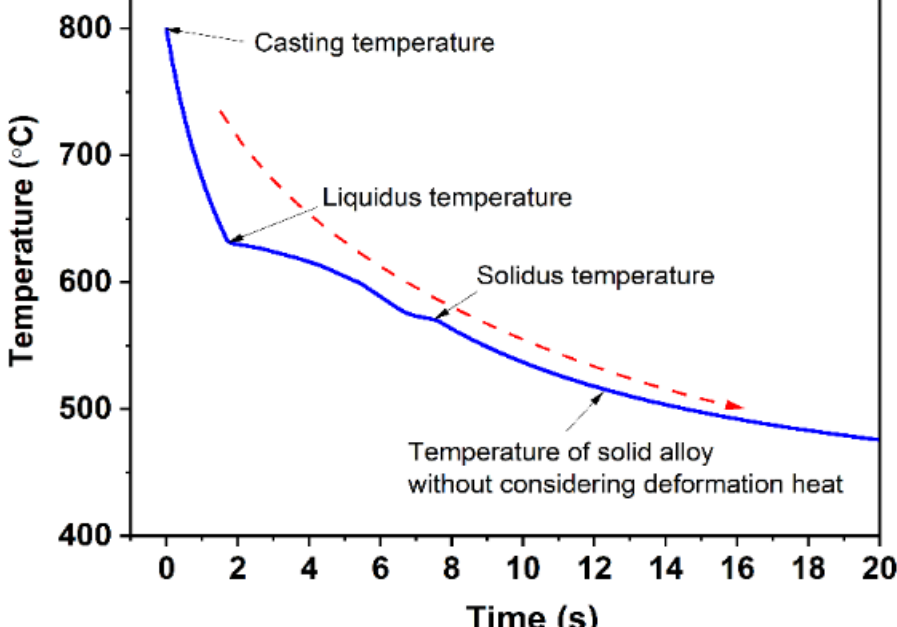
Figure 7. Temperature variation of the Al–6Mg melt in the roll-shoe gap with increasing time during continuous rheo-extrusion.